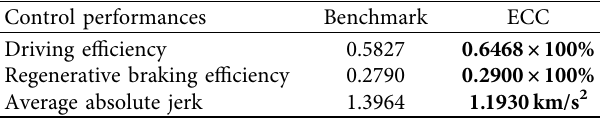
Table 2: Motor’s average efficiency and ride comfort by the benchmarked cruise control and the proposed ECC